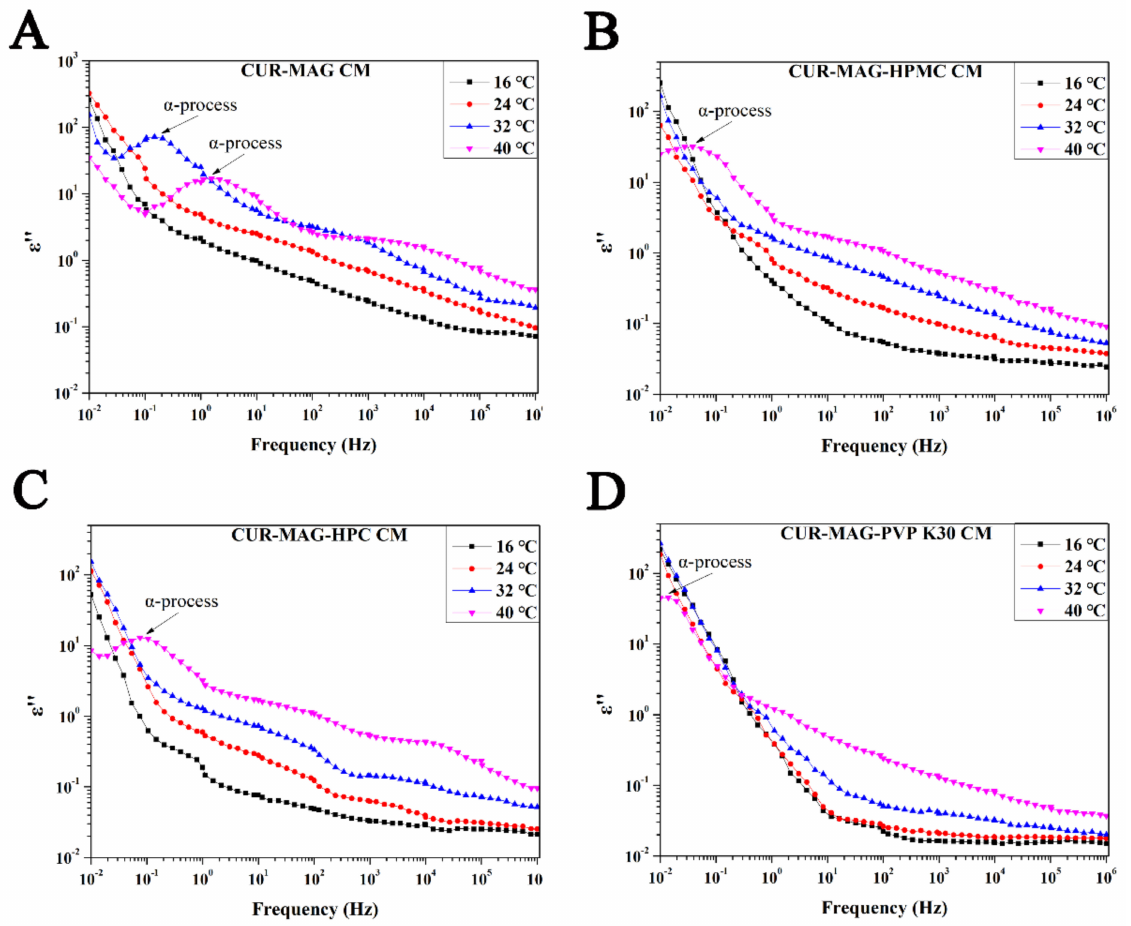
Figure 11. Dielectric loss spectra:( A ) CUR-MAG CM; ( B ) CUR-MAG-HPMC CM; ( C ) CUR-MAG-HPC CM; ( D ) CUR-MAG- PVP K30